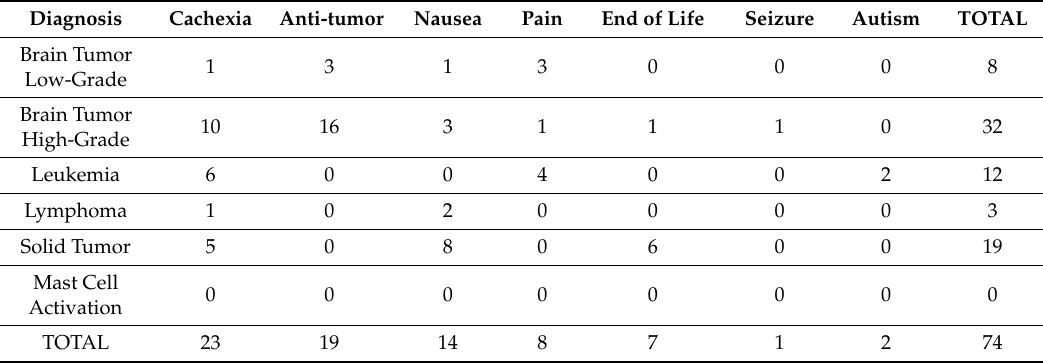
Table 3. Secondary indications for medical cannabis by diagnostic